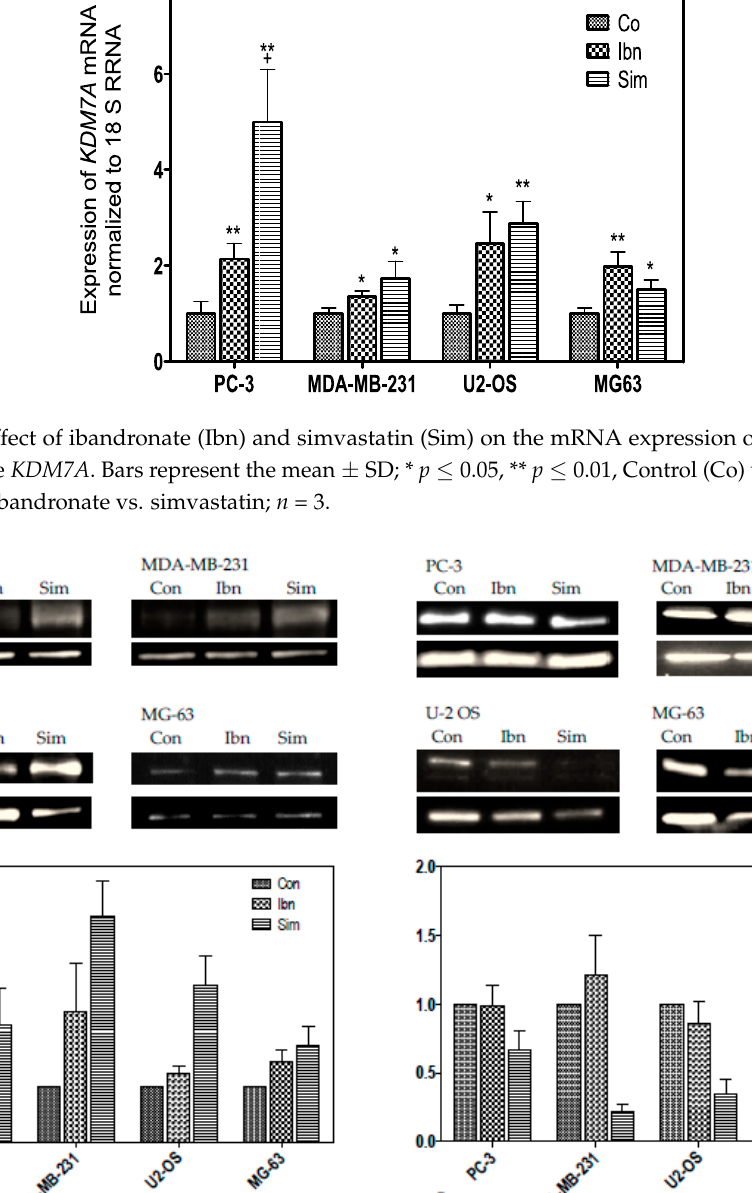
Figure 5. The effect of a simvastatin and ibandronate (treatment for 6 days with indicated EC50 concentrations as shown in Table 5) on the protein expression of the histone demethylase KDM7A is shown. The photographs show KDM7A (95 kD) in the upper lanes and the actin ACTA1 (42 kD) in the lower lanes for comparisons. “Con” refers to untreated control cells, “Ibn” to ibandronate-treated cells, and “Sim” to simvastatin-treated cells. Chemo-luminescence for the analysis of protein bands was measured with an image acquisition. Results of chemiluminescence measurements are given as means of three immunoblots.